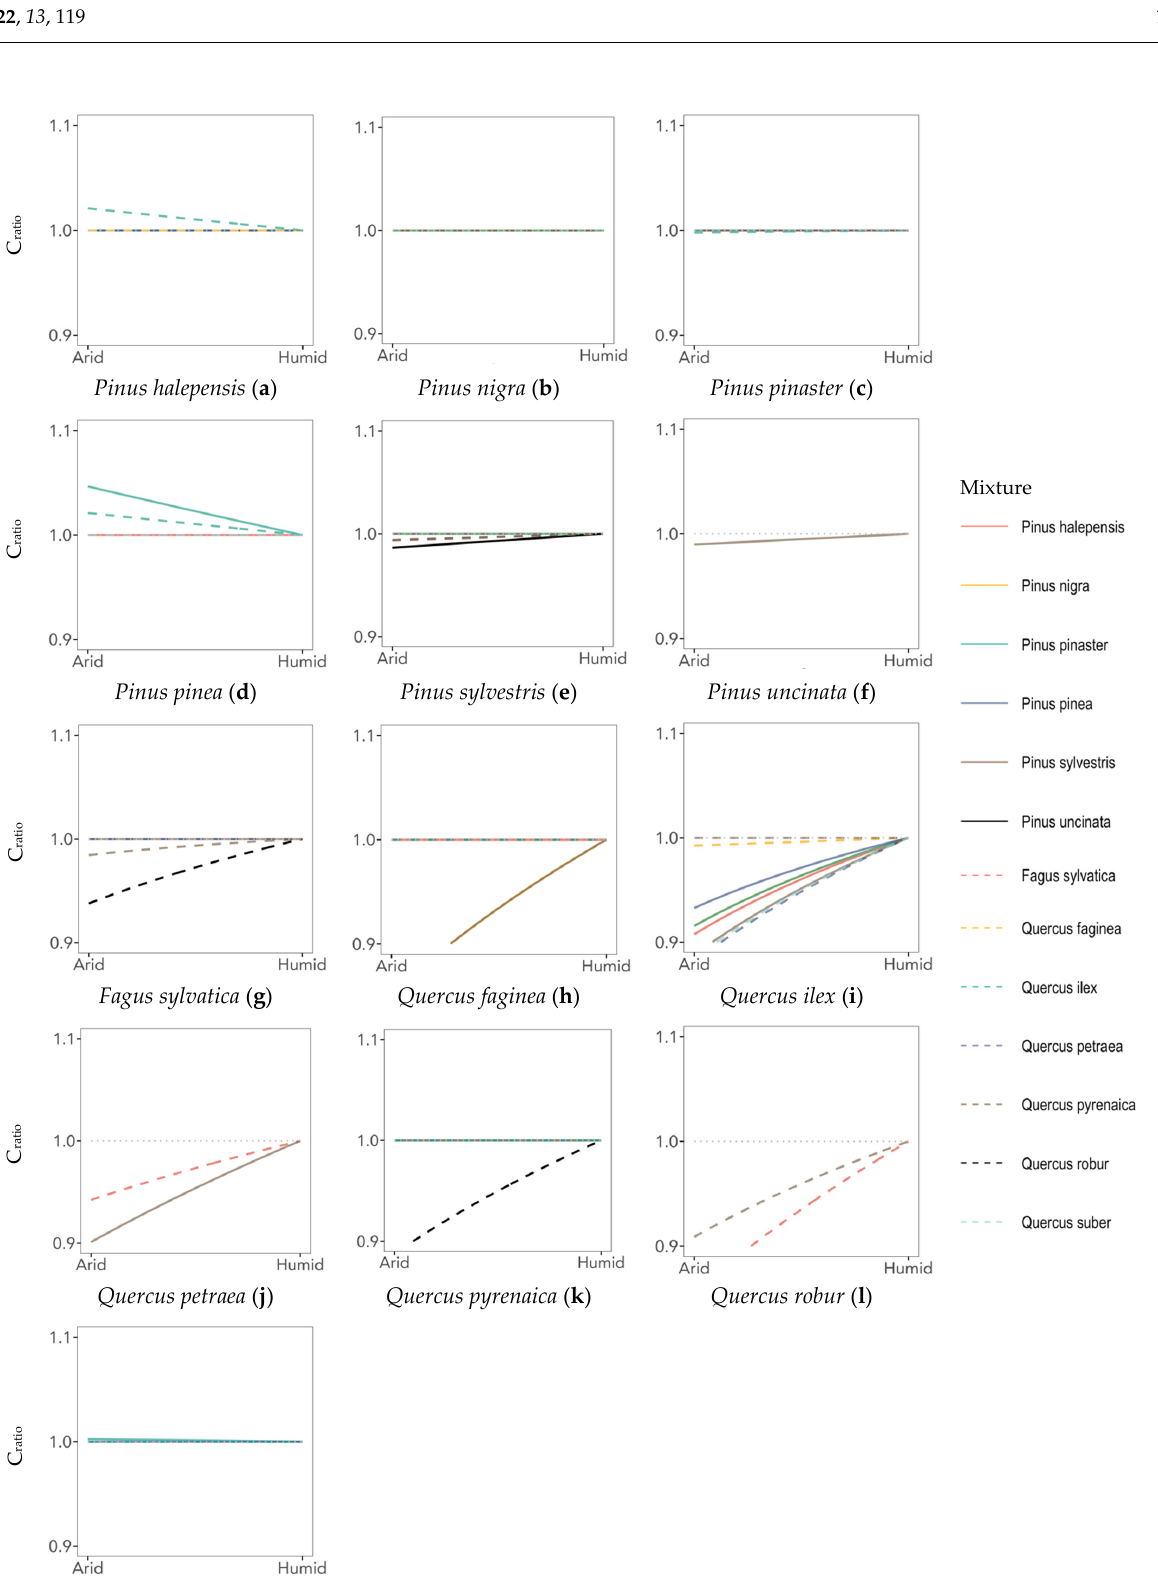
Figure 2. Variation of height along the aridity gradient ( x -axis), with Arid being the lowest M value and Humid the highest M found in the distribution of each species in each mixture composition. Letters a-m indicate the species name in order to make reference to them along the text. Note: C (ratio) ratio ( y -axis) represents whether height in mixed forests is higher (C (ratio) > 1) or lower (C (ratio) < 1) in more arid than humid places. All independent variables (excepting M and m i = 0. 5) have been fixed to the mean values for each